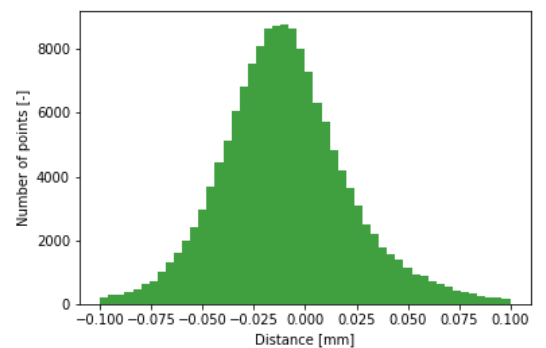
Figure 6: Example of distance histogram for group 3 of side